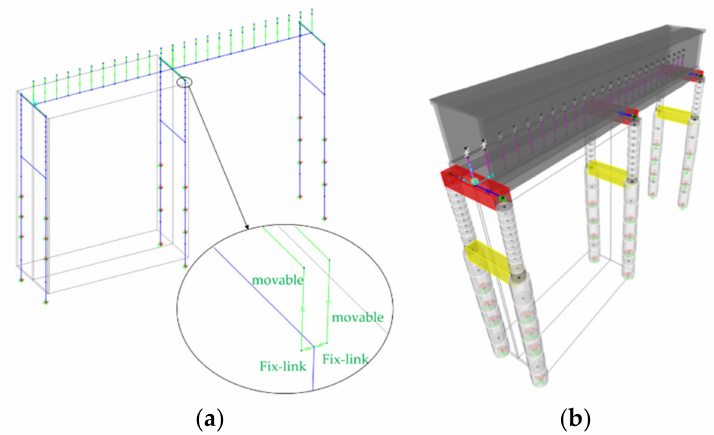
Figure 4. ( a ) FE models and connecting links; ( b ) 3D model